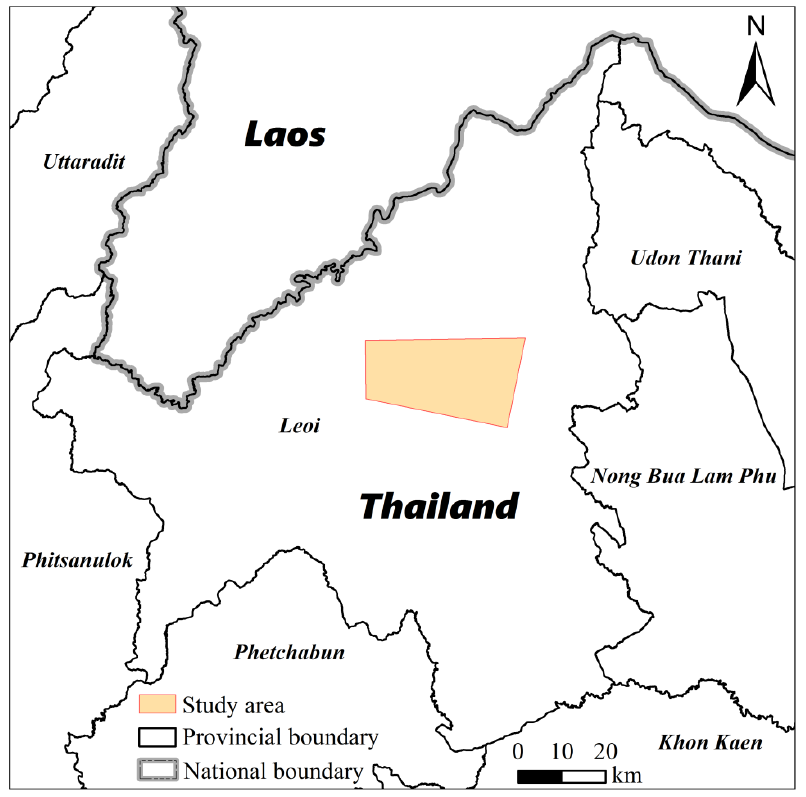
Figure 1. Study area.